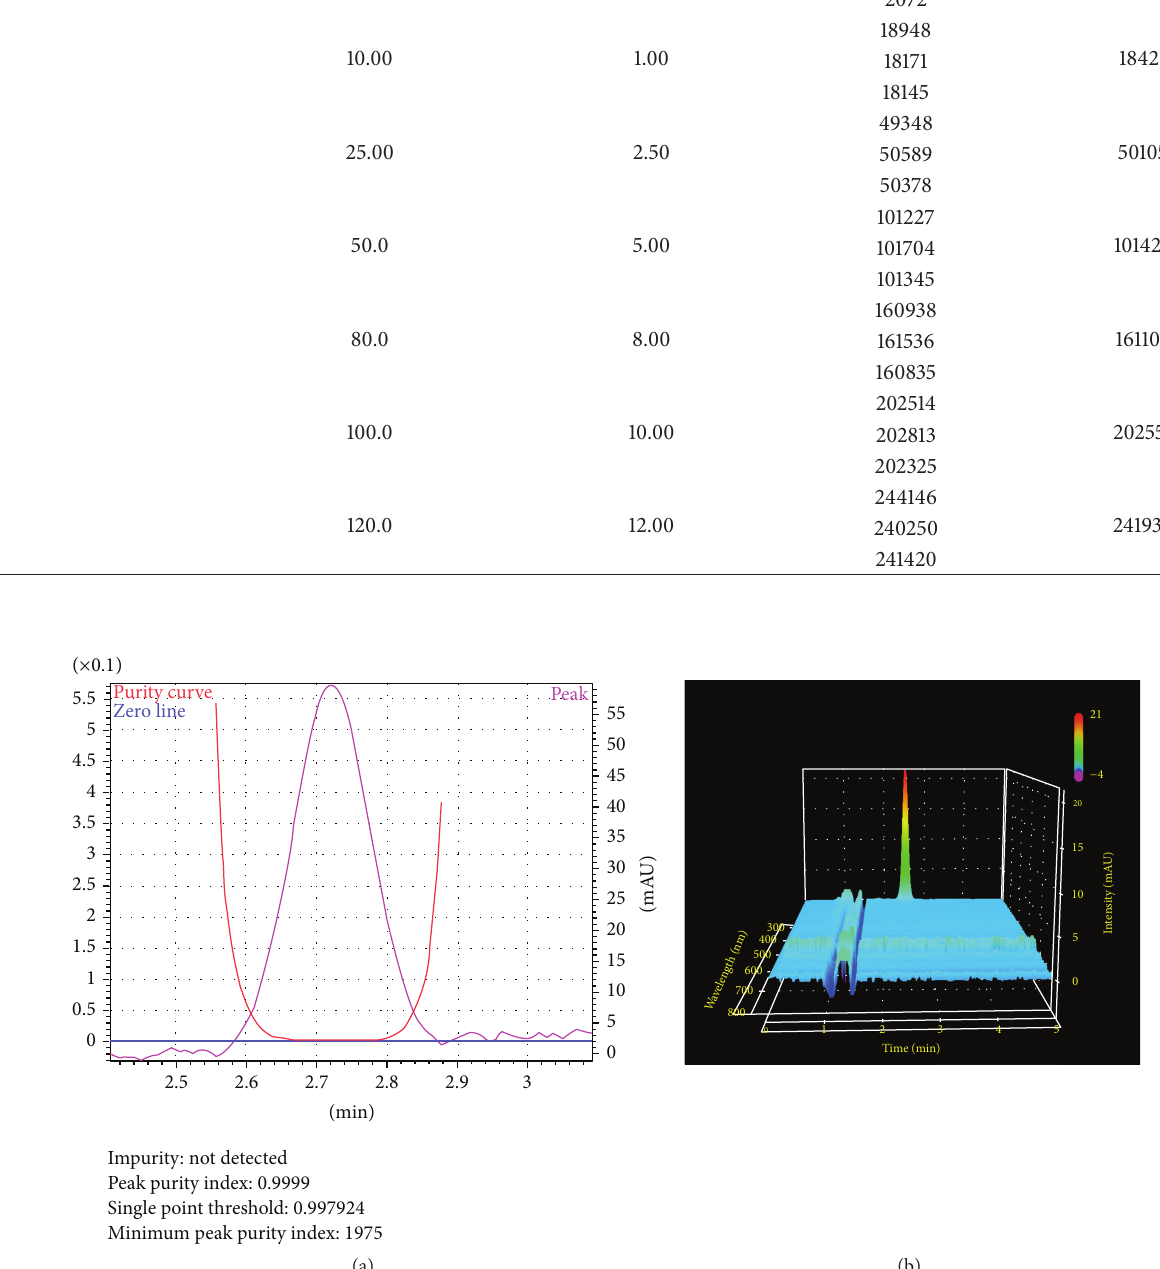
Figure 3: Peak purity of dissolution assay sample of rabeprazole sodium. (a) peak purity curve (b) In 3D visualization: peak retention time (min), absorbance (nm), and intensity (mAU) are presented in 𝑋 -, 𝑌 -, and 𝑍 -axes, respectively, from Shimadzu LabSolution